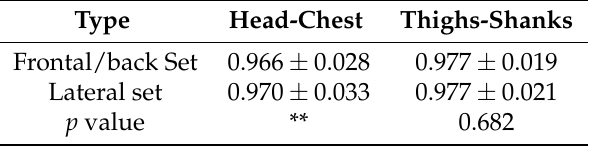
Figure 8. Acceleration correlation between different body segments, with different T ex . Table 7. Paired t -test on acceleration correlation between IMUs placed on different sides of body segments.